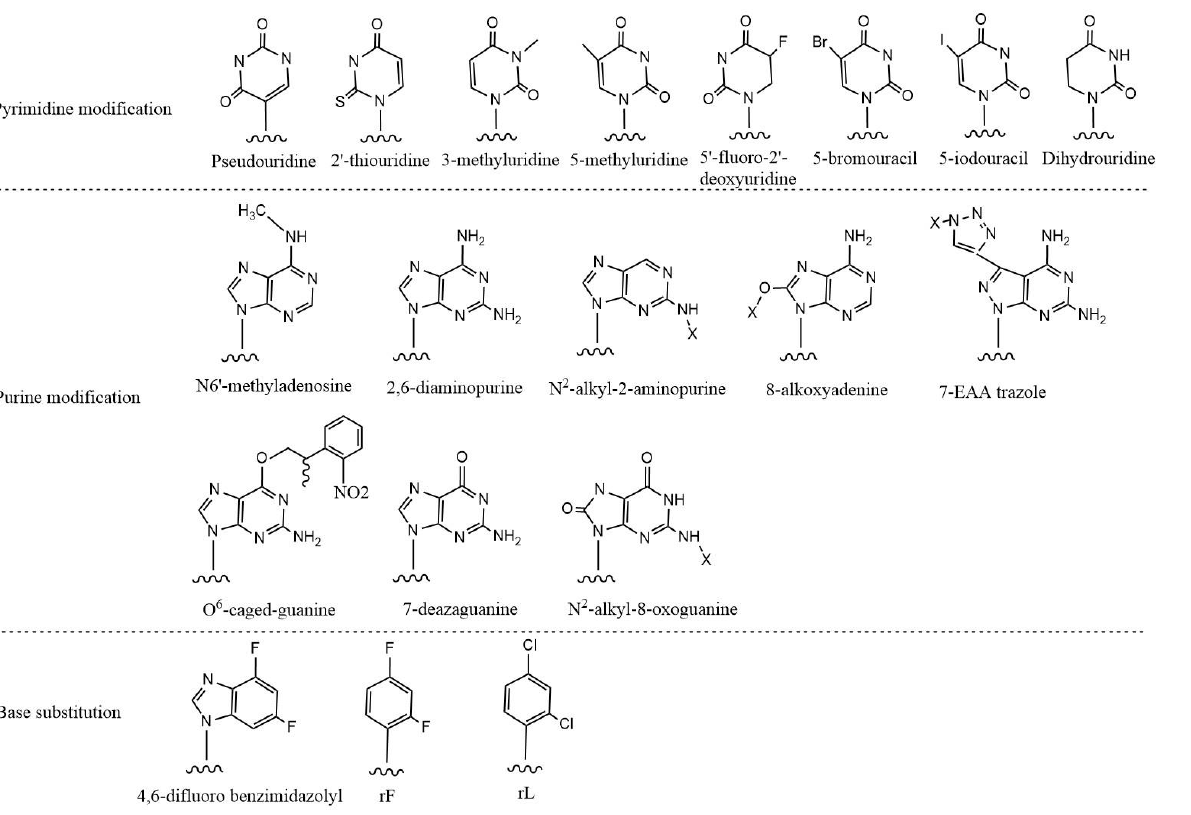
Figure 5. Chemical modification types of siRNA base.